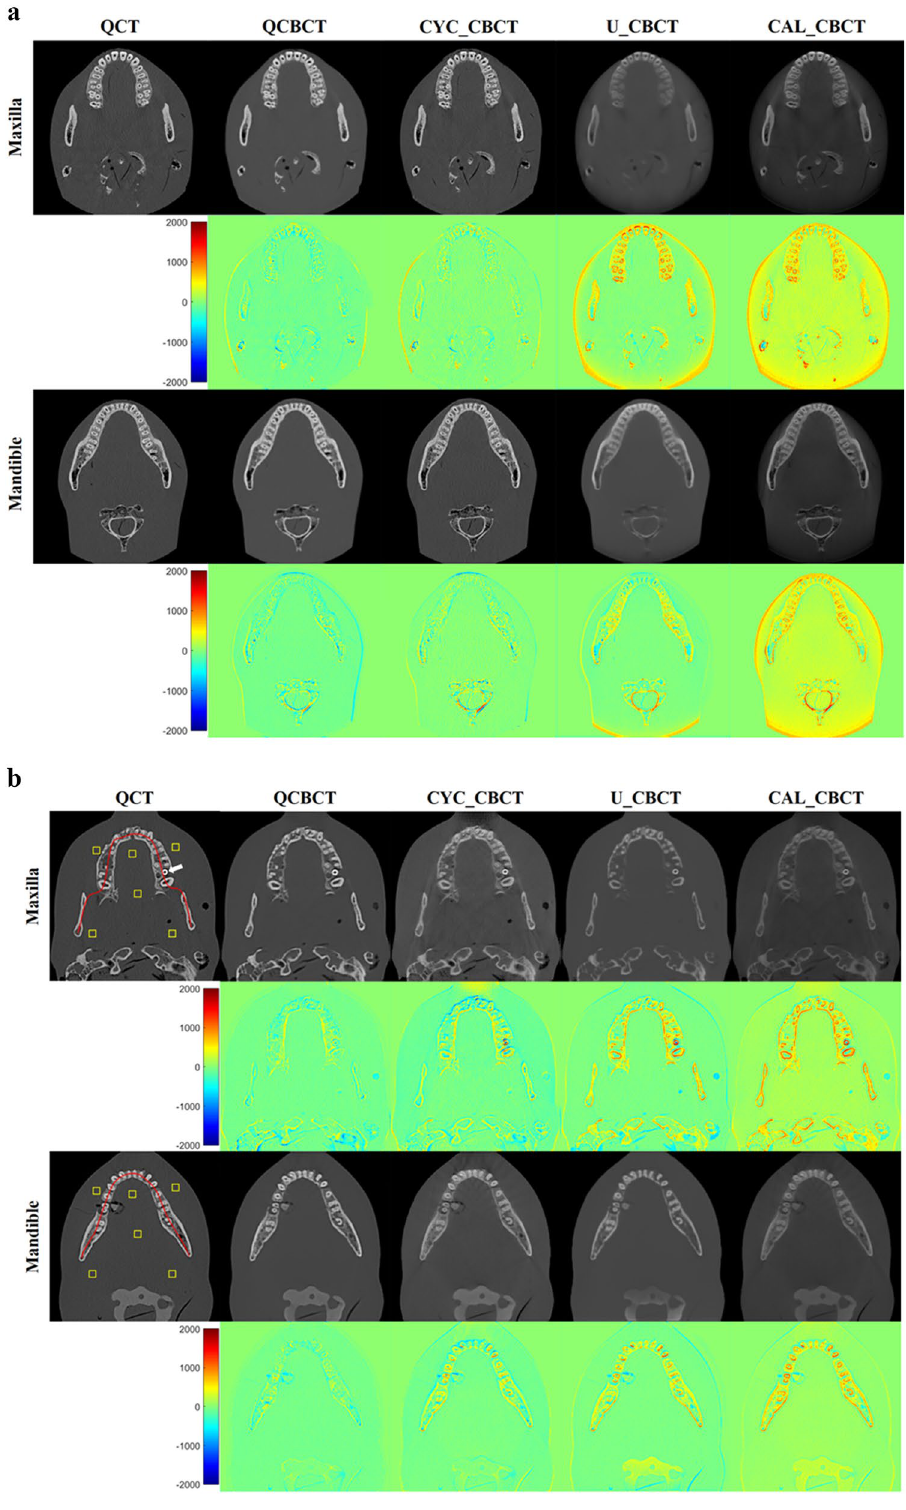
Figure 3. The axial slices of BMD images from the original QCT, their generations by deep learning methods (the first and third row), and their subtractions from the original QCT images (the second and fourth row) at the maxilla and the mandible. QCBCT produced by QCBCT-NET, CYC_CBCT by Cycle-GAN, U_CBCT by U-NET, and CAL_CBCT by only calibration from ( a ) training datasets under condition of 90 kVp and 10 mA, ( b ) test datasets under condition of 80 kVp and 8 mA, and ( c ) test datasets under condition of 90 kVp and 10 mA. The yellow squares shown in the QCT image were ROIs for calculation of the spatial nonuniformity (SNU), the red curve shown in the QCT image was the dental arch for BMD (voxel intensity) profiles, and the white arrows shown in the QCT images indicated the dental implant at the maxilla in ( b ), and the dental restorations at the maxilla in ( c